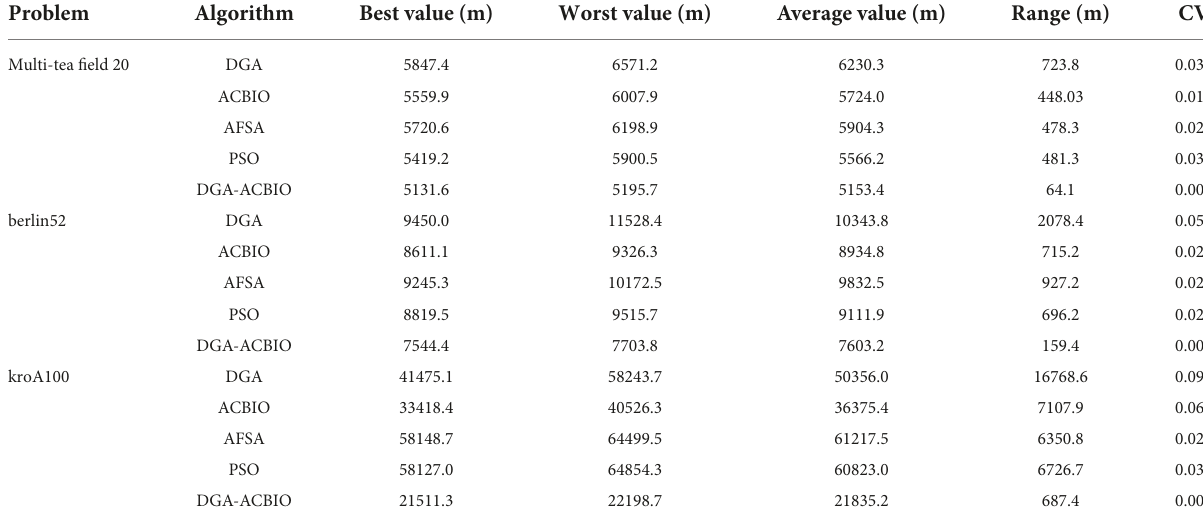
TABLE 3 Simulation results for different traveling salesman problems.